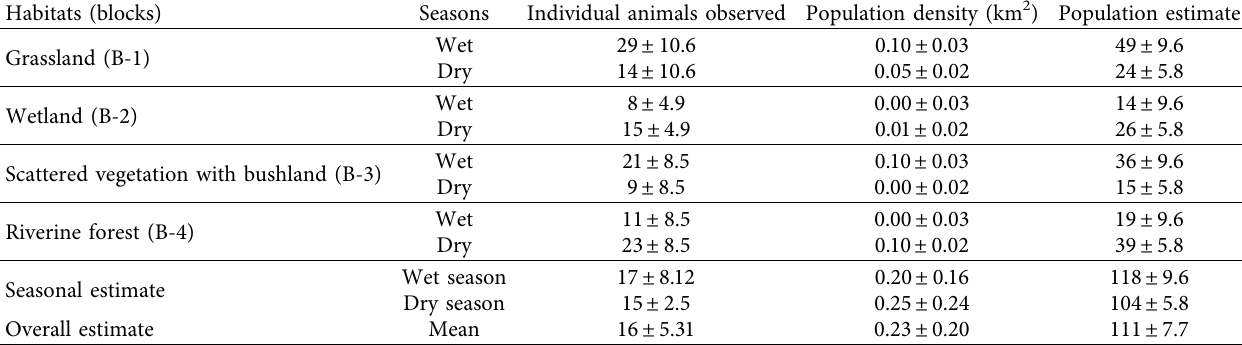
Table 2: Population estimate of waterbuck in the Nechsar national park (Mean ± SD).